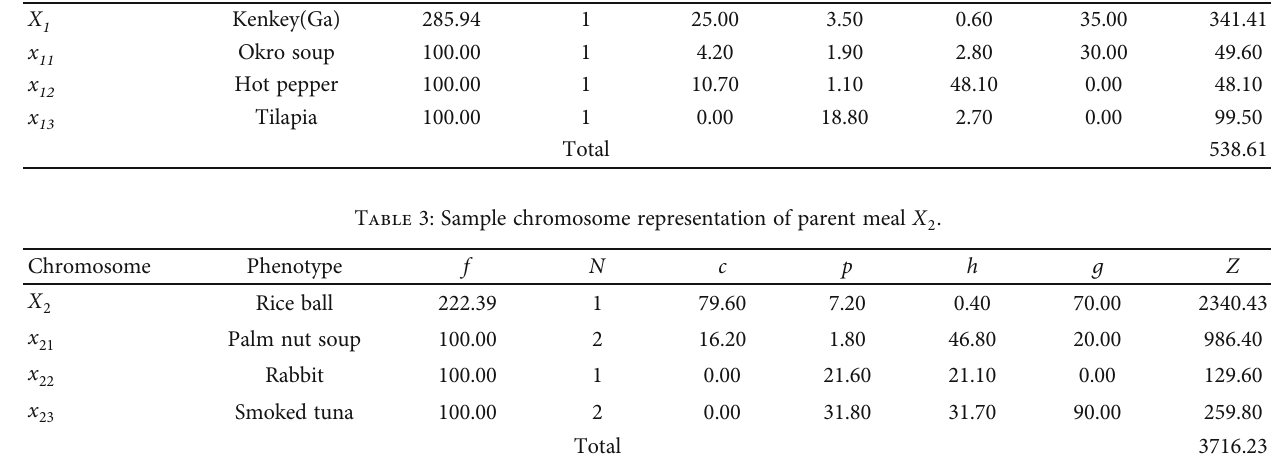
Table 2: Chromosome representation of a meal.